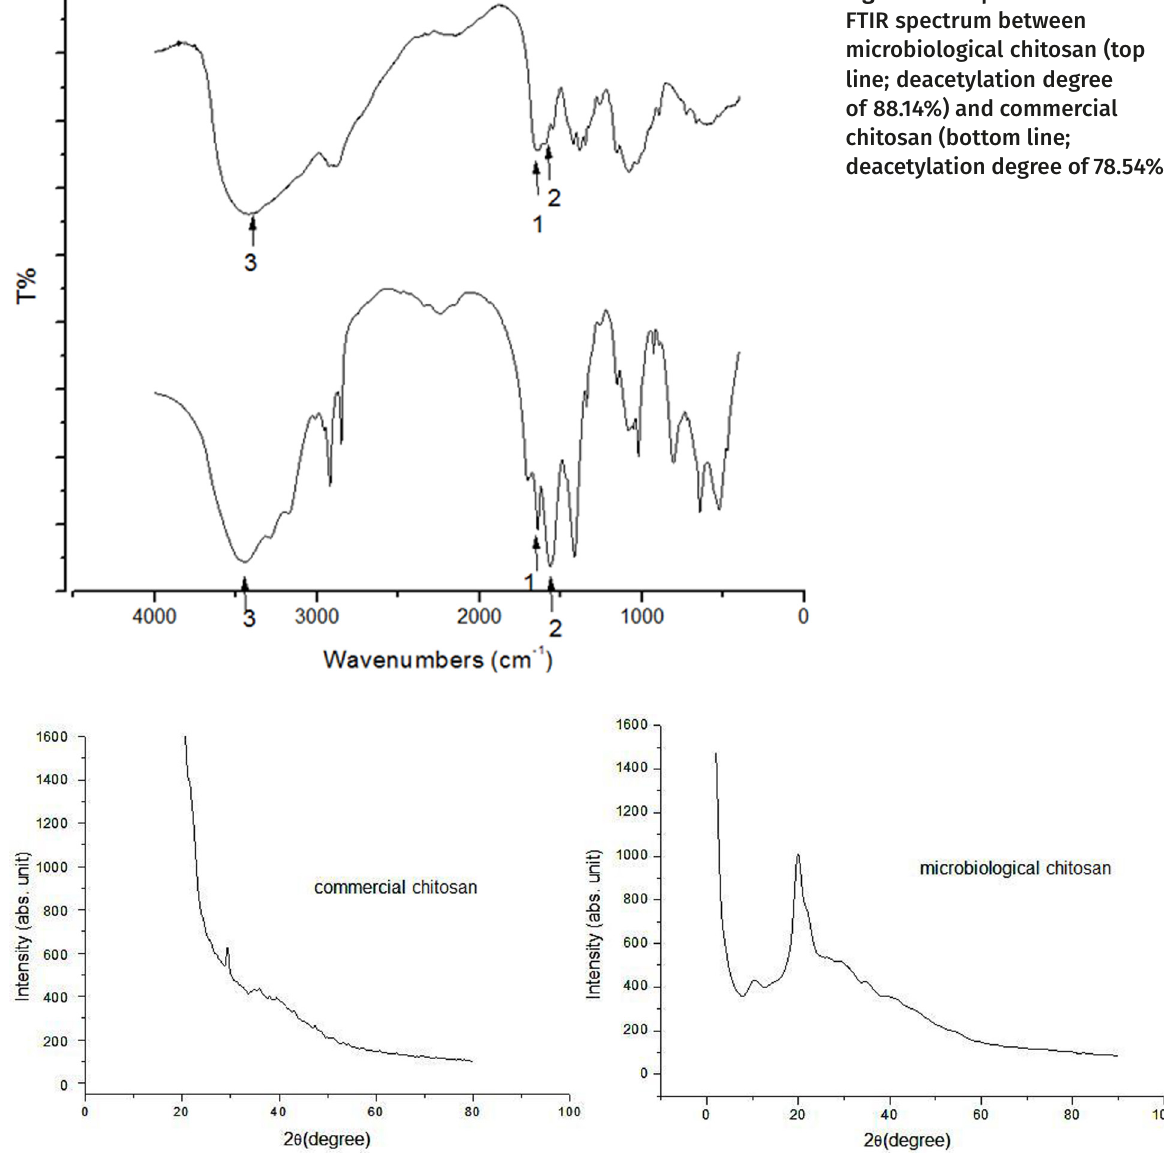
Figure 1. Comparative